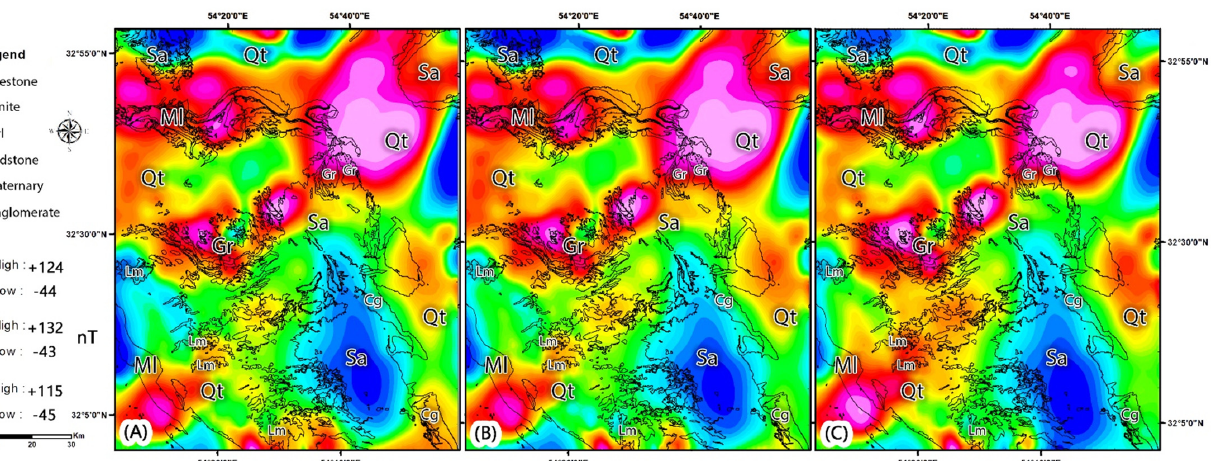
Figure 8. ( A ) First vertical derivative map; ( B ) Analytical signal map; ( C ) TDX map for the study area. Figure 8B shows the resulting map derived from applying the analytical signal filter. This Figure indicates the presence of masses with multiple magnetic anomalies and high- lights the approximate position of the edges of the magnetic masses in the study area. In Figure 8B, the anomalous dipoles are mostly found with igneous rocks and the Quater- nary background (northeastern, northwestern, and southwestern segments). The TDX